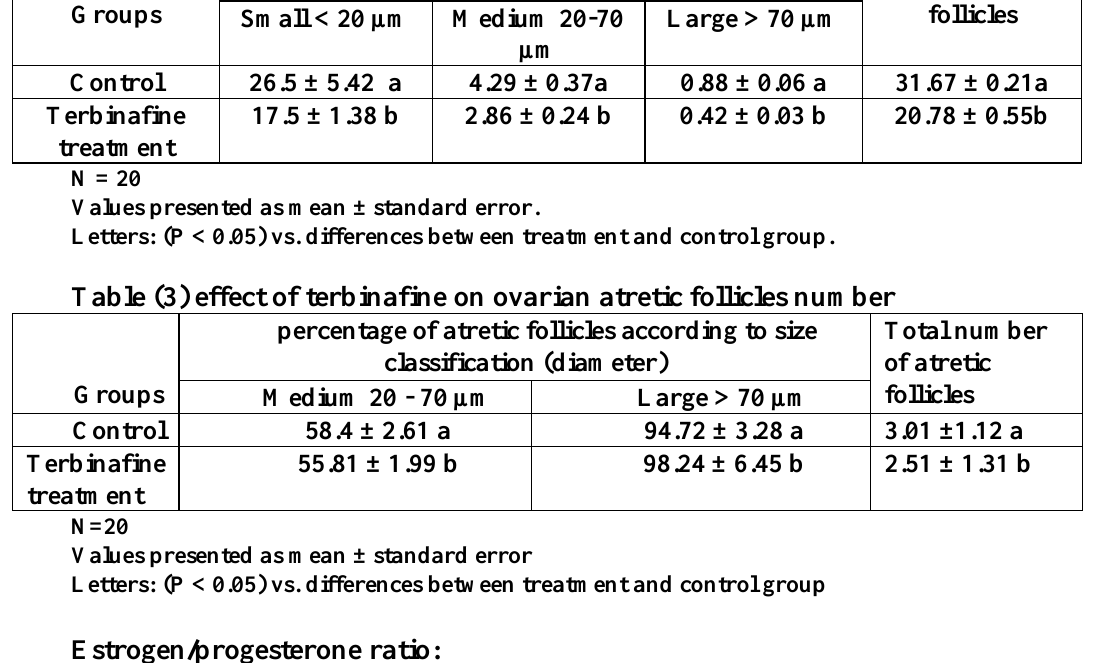
Estrogen/progesterone ratio: